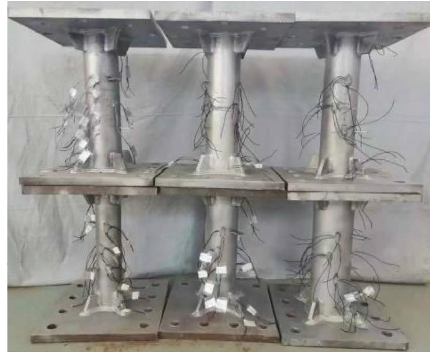
Figure 5: Specimens before